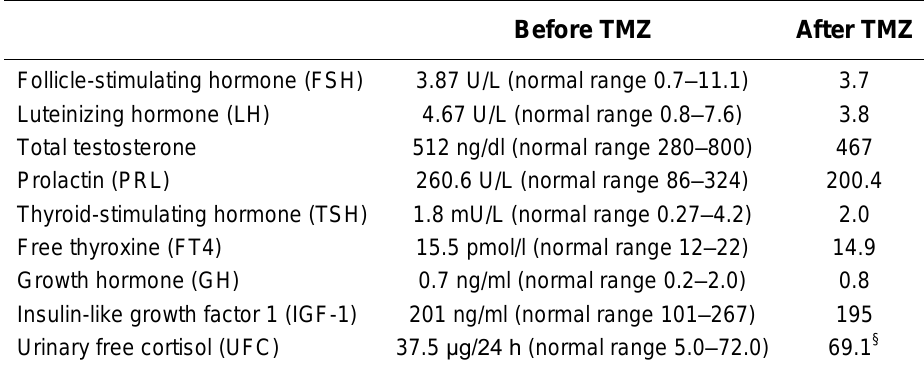
Endocrine Evaluation Before and After TMZ